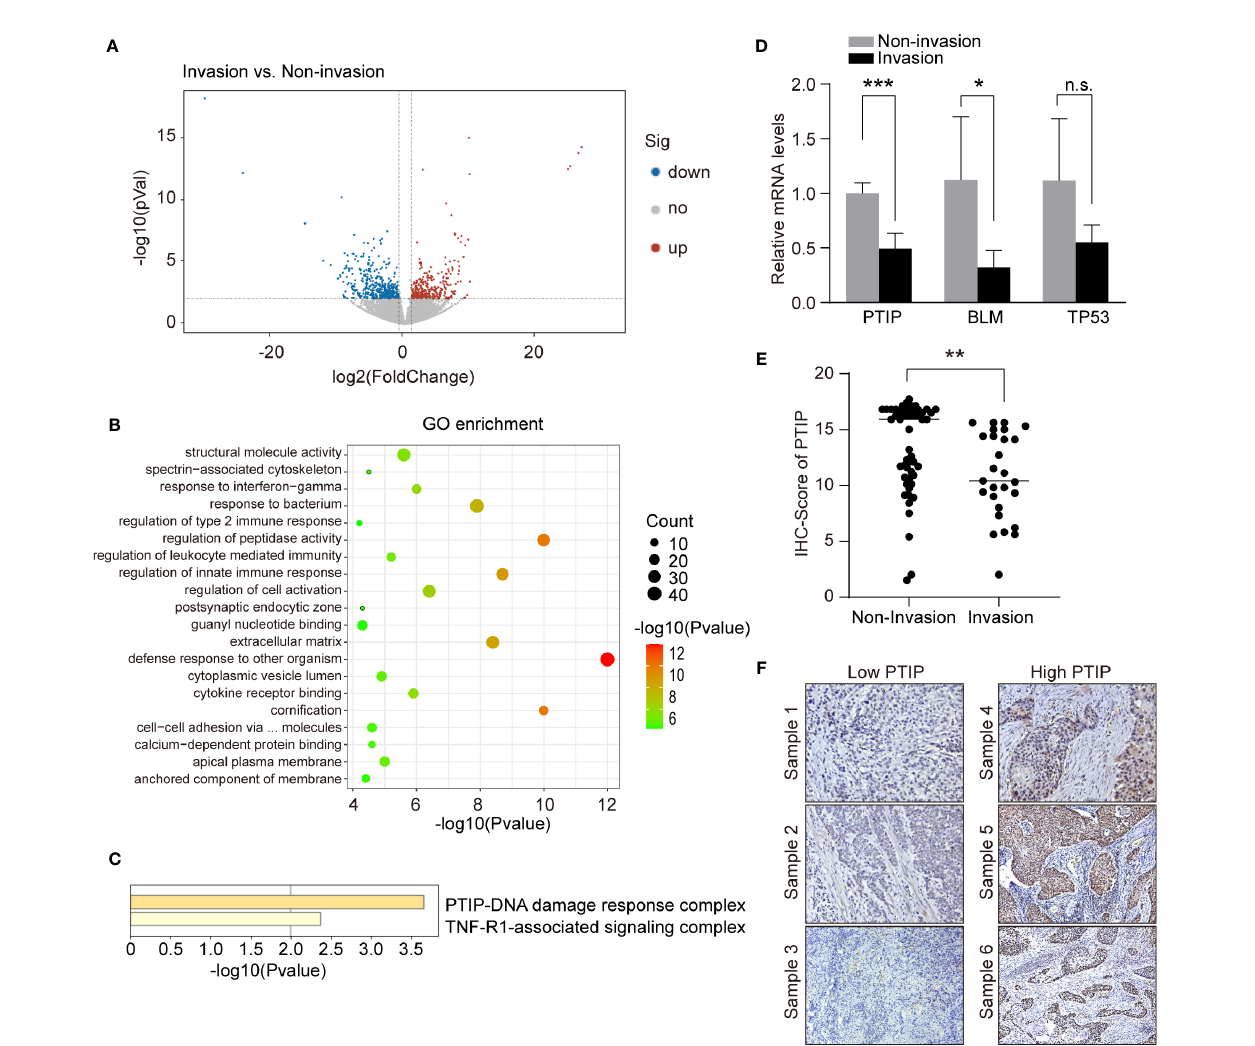
FIGURE 1 | PTIP expression negatively correlates with lymph node metastasis in ESCC. (A) Volcano plot showing differentially expressed genes between tumor biopsies with and without lymph node metastasis using RNA-seq. Volcano plot shows the log2 fold change (x-axis) and signi fi cance ( − log10*adjusted P -value; y-axis) with signi fi cantly downregulated and upregulated genes shown in blue and red, respectively (adjust P < 0.01 and |log2Foldchange| > 0.9). (B) GO enrichment of differentially expressed genes from (A) . (C) Functional enrichment analysis of differentially expressed genes from (B) using CORUM gene set. (D) quantitative RT-PCR analysis of genes that downregulated in lymph node metastasis positive ESCC samples. Unpaired, two-tailed Student ’ s t-test; * P < 0.05; *** P < 0.001; n.s., not signi fi cant. (E) IHC score for PTIP in ESCC tumor sections. Unpaired, two-tailed Student ’ s t-test; ** P < 0.01. (F) Representative IHC images for PTIP in ESCC tumor sections. Low PTIP and high PTIP groups were divided based on the PTIP immunostaining intensity scores mentioned in method. Cut off for high and low PTIP expression in ESCC was de fi ned < or > 11. Percentage of invasion and non-invasion in ESCC groups is depicted in Table 4